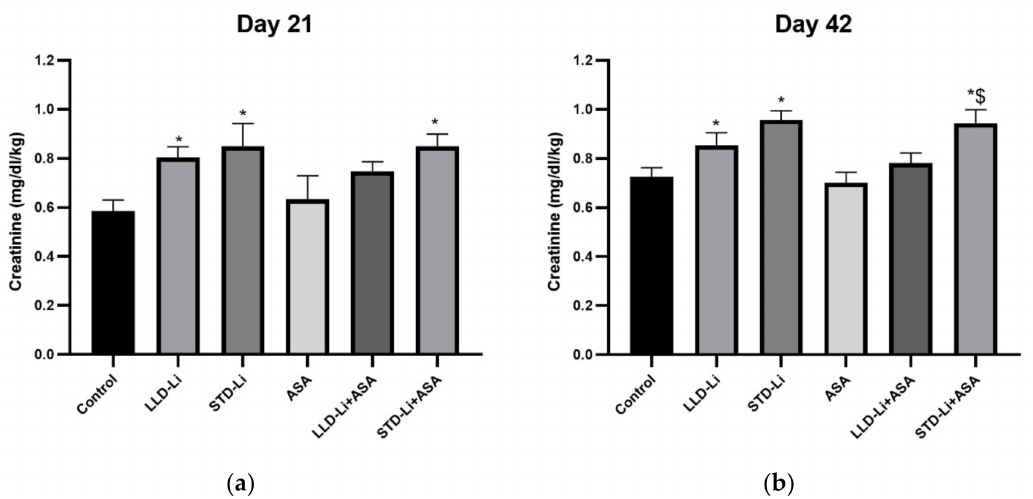
Figure 3. Plasma creatinine levels in aspirin + Li-treated rats. Rats were fed regular food (control) or Li-containing food (LLD-Li or STD-Li) for 42 days. Low-dose ASA (1 mg/kg, ip) was administered alone or as add-on to Li. On days 21 ( a ) and 42 ( b ) blood was collected, plasma separated, and creatinine levels determined as described in Materials and Methods. Presented are creatinine levels adjusted to rat’s body weight. The figure summarizes the combined results of two independent experiments demonstrating a similar pattern. Results are the means ± SEM of 9–12 rats per group. ( a ) Two-way ANOVA: ASA effect, F 1,64 = 0.6556, p = 0.6874; Li effect, F 2,64 = 10, p = 0.0002; aspirin x Li interaction: F 2,64 = 0.3770, p = 0.6874. Post hoc Fisher’s LSD test: Control vs. LLD-Li, p = 0.0274; Control vs. STD-Li, p = 0.0005; Control vs. STD-Li + ASA, p = 0.0064. ( b ) Two-way ANOVA: aspirin effect, F 1,112 = 1.031, p = 0.312; Li effect, F 2,112 = 14.79, p < 0.0001; aspirin X Li interaction: F 2,112 = 0.2559, p = 0.775. Post hoc Fisher’s LSD test: Control vs. LLD-Li, p = 0.045; Control vs. STD-Li, p = 0.0003; Control vs. STD-Li + ASA, p = 0.0006; LLD-Li + ASA vs. STD-Li + ASA, p = 0.0095. Asterisks and symbols denote the following: *— p < 0.05 vs. Control, $— p < 0.05 vs. LLD-Li + ASA. Abbreviations: ASA—acetylsalicylic acid, LLD—low-low dose, Li—lithium, STD—standard